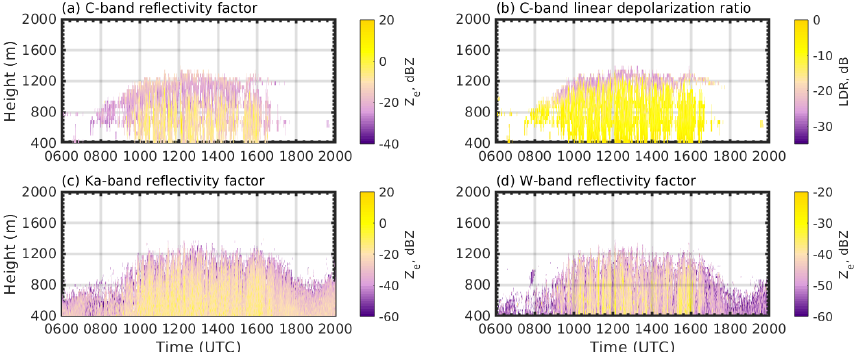
Figure 1. The 1min averaged radar returns for 9 May 2018 in Hyytiälä of (a) the C-band reflectivity factor, (b) the C-band linear depolar- ization ratio, (c) the Ka-band reflectivity factor and (d) the W-band reflectivity factor. The CBL development can be visually seen from the radar returns. Note different colour bar scale limits in the graphs.